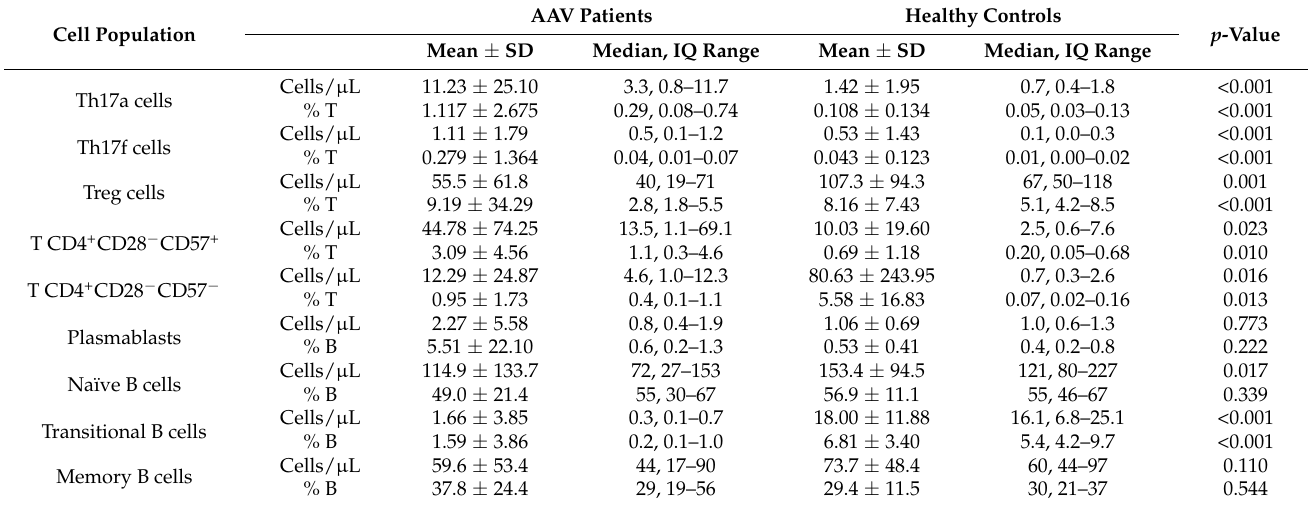
Table 4. T and B cell subsets in the AAV patients and the healthy controls.